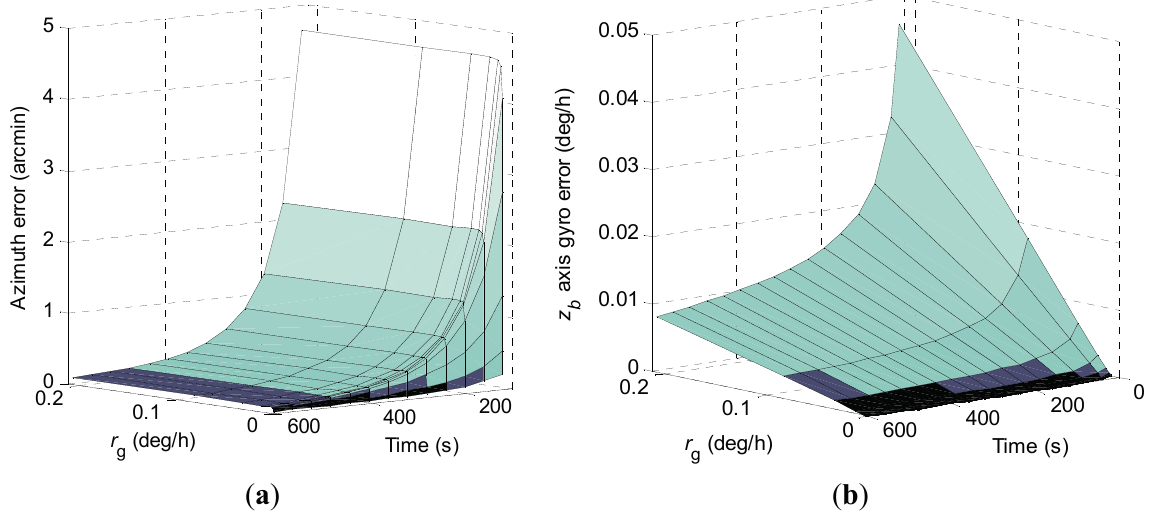
Figure 9. Convergence curves of the azimuth error and the z b axis gyro error within 600 s by the constrained KF scheme. ( a ) Azimuth error; ( b ) z b axis gyro